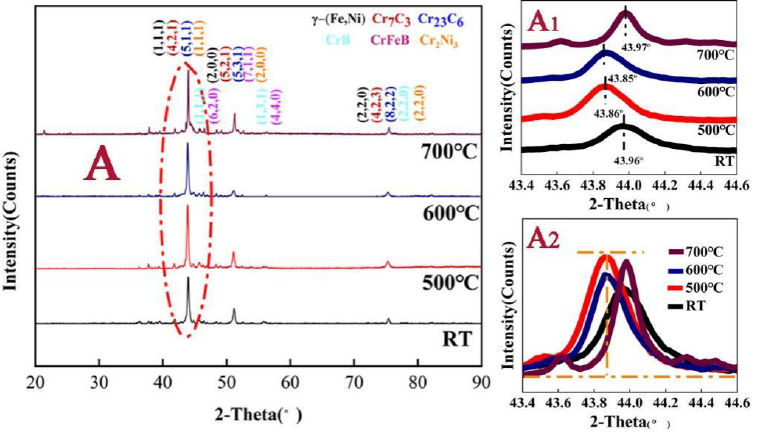
Figure 1. XRD patterns of the composite with different heat−treatment temperatures.